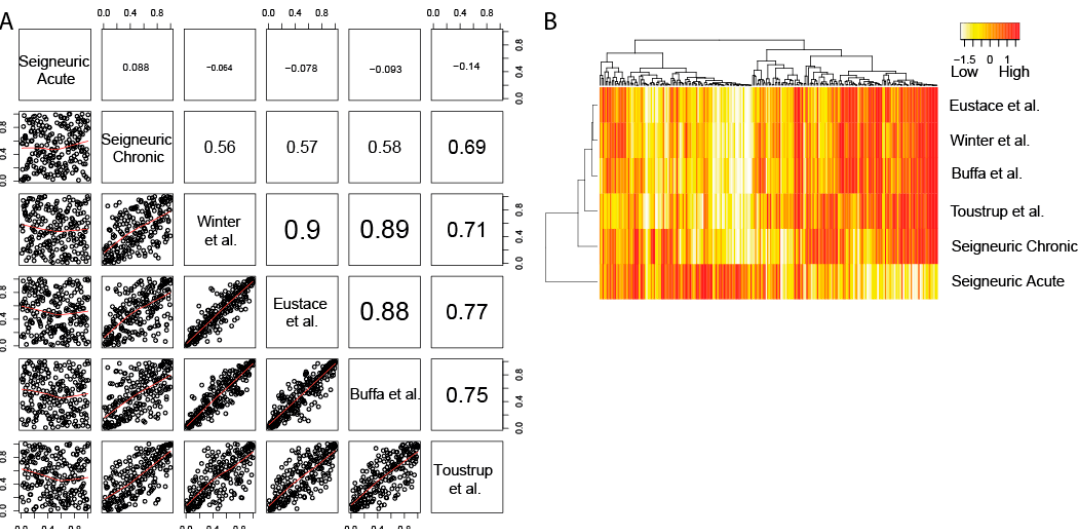
Figure 2. Correlations and clustering of the hypoxia scores from the clinical hypoxia profiles and the Seigneuric acute and chronic in vitro hypoxia profiles in 224 HNSCC patients. ( A ) Spearman correlations (upper right panels) and scatter plots (lower left panels) of all possible pairs of hypoxia profiles for 224 patients. All Spearman correlations were significant at the p < 0.0001 level. ( B ) Heatmap showing the scores for the four hypoxia profiles and in vitro profiles as indicated in 224 patients.